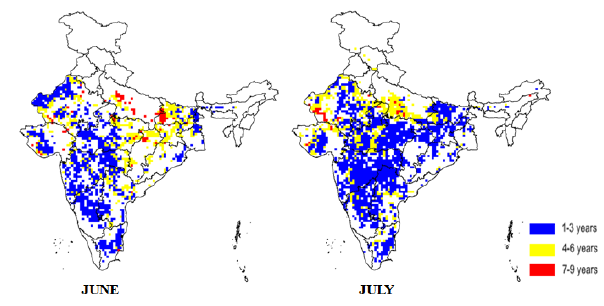
Figure 5: Drought frequency maps for June and July.